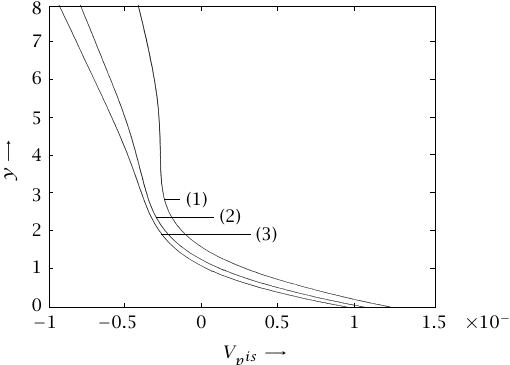
Figure 4.13 . Induced steady transverse velocity component of the particle in the boundary layer for R = 500, 4 = 0 . 05. (1) X = − 1, λ = 0 . 01, (2) V p is X = − 1, λ = 0 . 36, (3) X = − 1, λ = 0 .